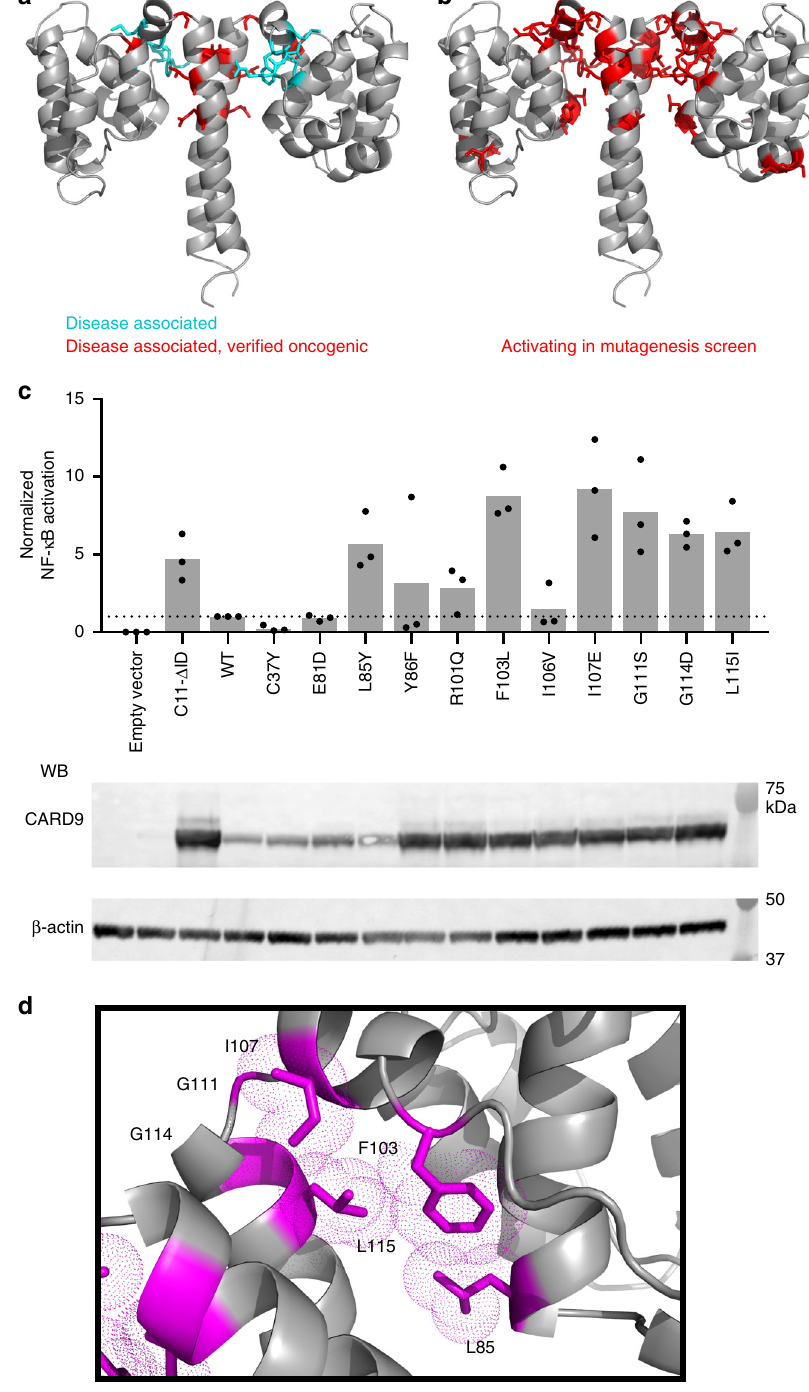
Fig. 2 The CARD-coiled-coil interface is critical for maintenance of an autoinhibited state. a Disease associated mutants in CARD11 (cyan) and disease associated mutants for which follow-up work con fi rmed that the mutants were oncogenic (red), mapped onto the homologous residues of CARD9 in the lowest energy NMR structure. b Hyperactivating CARD11 mutants identi fi ed by Chan et al. 30 in a randomized mutagenesis screen, mapped onto the homologous residues of CARD9 2 − 142 . c Normalized NF- κ B activation in HEK-293 cells upon overexpression of WT or mutant full-length CARD9. The known activator CARD11- Δ ID was used as a positive control. Three biologically independent experiments were undertaken, the outcomes of which are shown as dots. The mean value for each construct is depicted as a gray bar. Dotted line represents the value of the WT construct, to which the other values were normalized. Representative western blot is shown for CARD9, demonstrating the total protein expression levels of the constructs. Molecular weights of protein standards are indicated. Source data are provided in Source Data fi le. d The CARD9 CARD-coiled-coil interface, with residues for which mutation consistently activates NF- κ B signaling depicted in magenta; sidechain heavy atom van der Walls radii are depicted as dotted